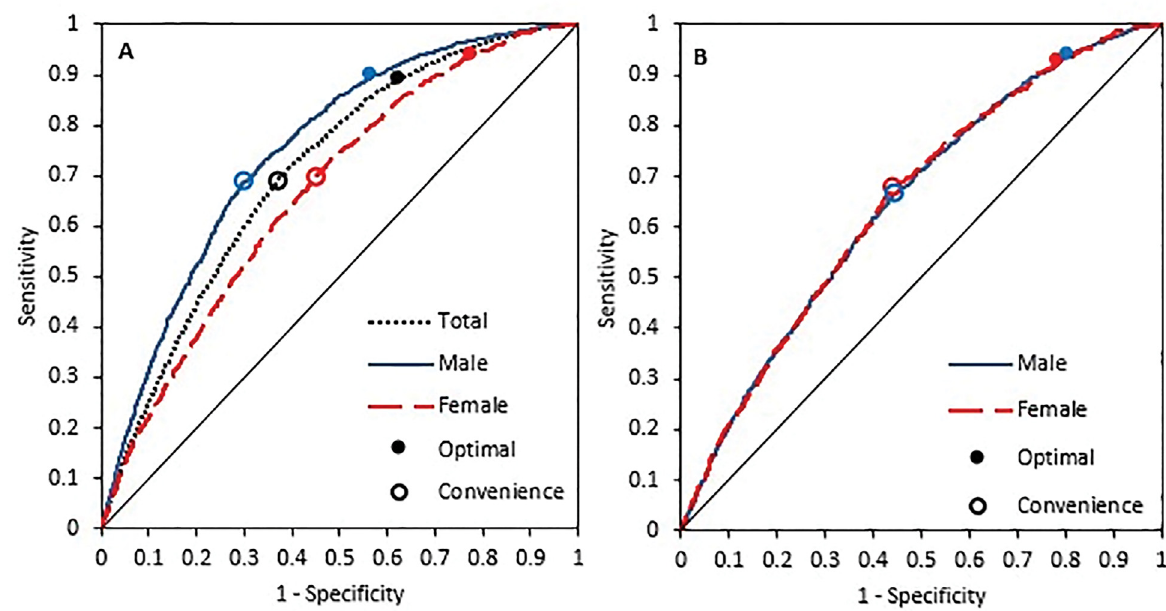
Fig 1. ROC curves for MeS using BMI. (A) In this chart metabolic syndrome was defined as having 3 of 5 components. (B) In this chart metabolic syndrome was defined without the waist